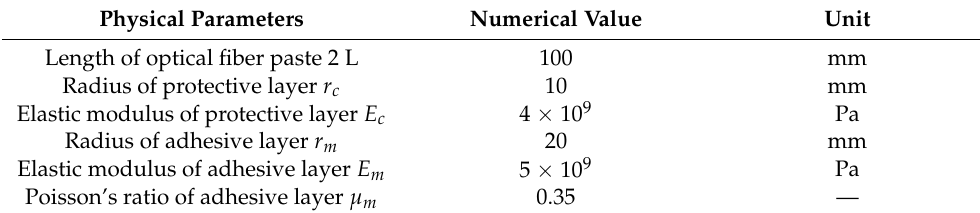
Table 1. Physical parameters of the strain-sensing transfer model. Physical Parameters Numerical Value Unit Length of optical fiber paste 2 L 100 mm Radius of protective layer r c 10 mm Elastic modulus of protective layer E c 4 × 10 9 Pa Radius of adhesive layer r m 20 mm Elastic modulus of adhesive layer E m 5 × 10 9 Pa Poisson’s ratio of adhesive layer µ m